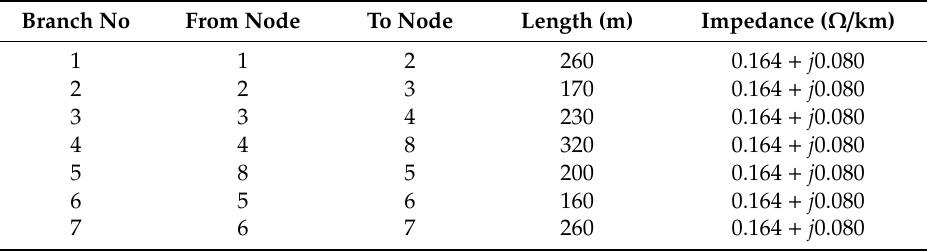
Table A3. Power system parameters of the system.